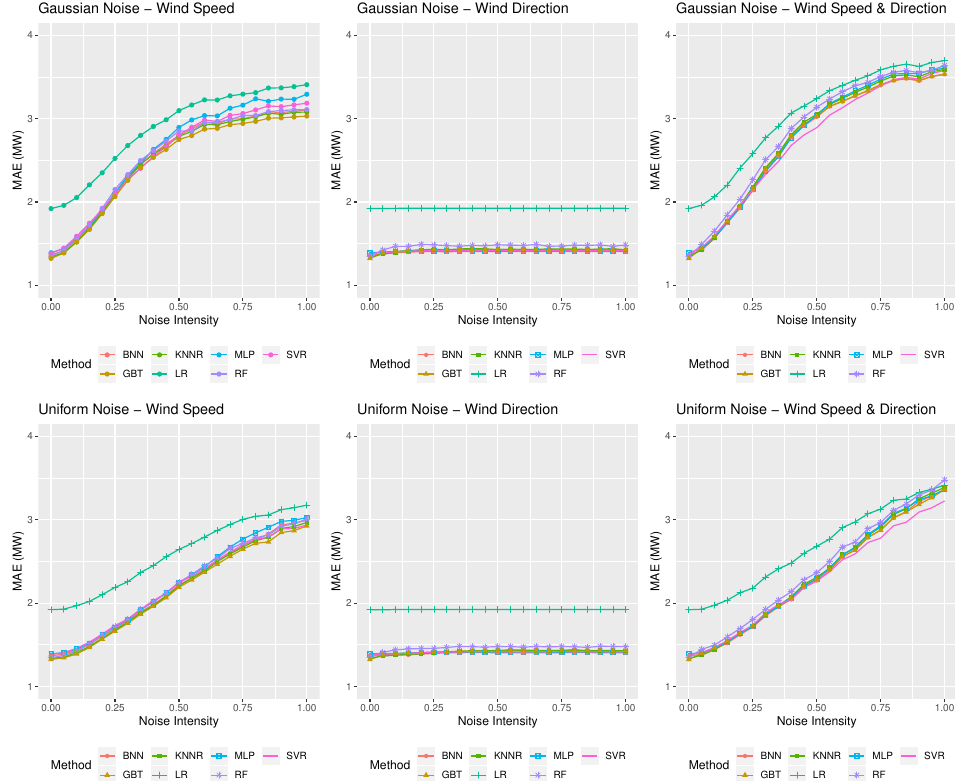
Figure 6. Forecasting performance in terms of wind power point forecasts (MAE, measured in MW) of the statistical and ML methods considered in this study for the Rokas wind farm when different types of noise and noise intensities are considered. The three panels on the top display the accuracy of the methods for the case of the Gaussian noise of various intensities, σ , applied to wind speed forecasts, wind direction forecast, and both, respectively. The three panels at the bottom display the same results for the case of the uniform noise of various intensities s